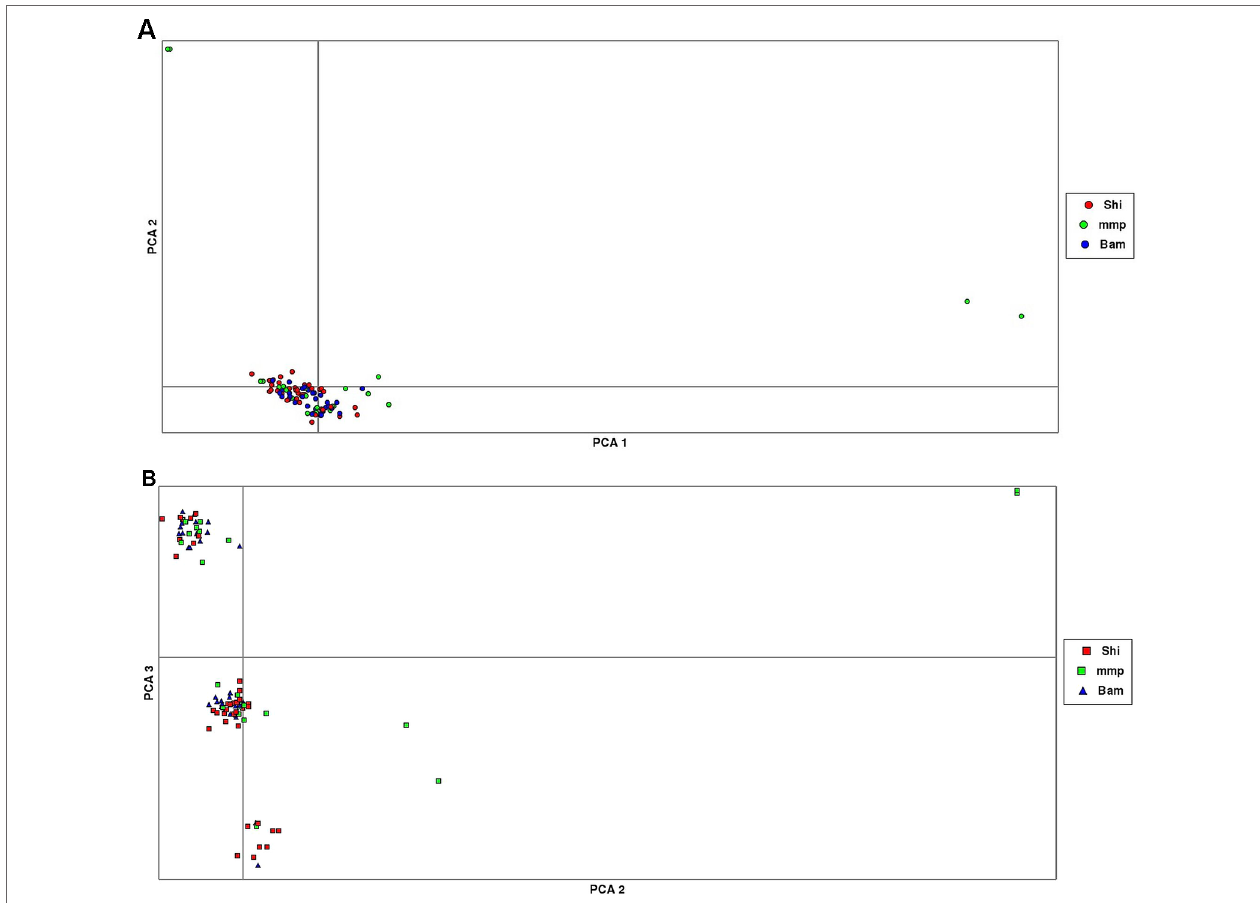
FIGURE 3 | Principal component analysis (PCA) plots showing clustering of samples collected from Mombasa Marine Park (MMP), Shimoni (Shi), and Bamburi (Bam). (A) (PCA1, PCA2) showing one major cluster grouping samples from all localities and two minor clusters, which consists of samples from the marine park only; (B) , PCA (PCA2, PCA3) showing three clusters consisting of samples from all localities.